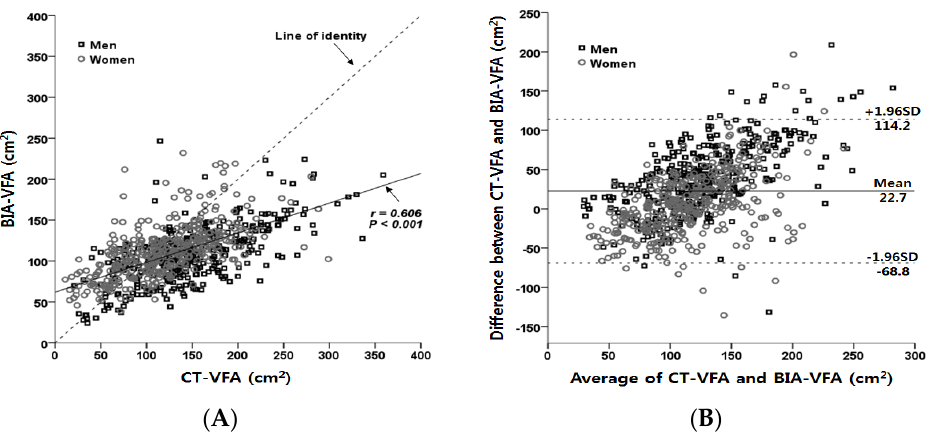
Figure 4. Correlation between VFA measured by CT and VFA estimated by BIA ( A ) and Bland-Altman plot for comparison between two methods ( B ) in subjects who performed CT and BIA within seven days.